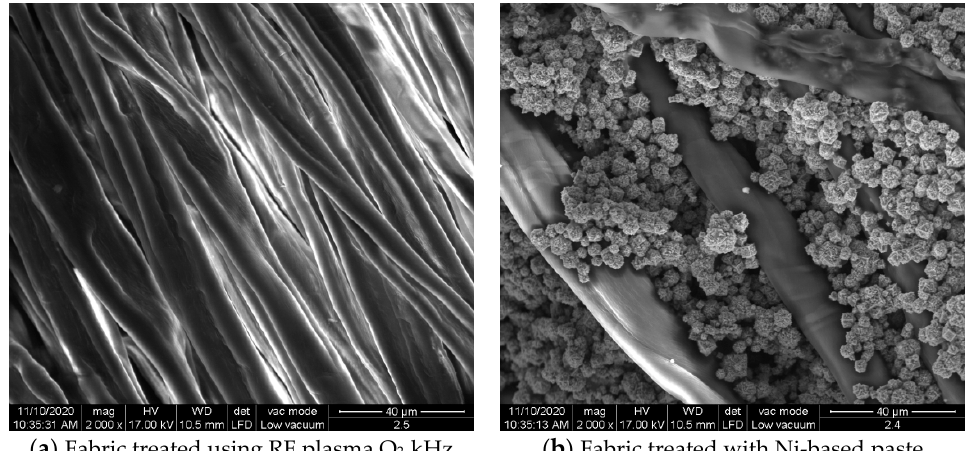
Figure 5. The sample was treated using RF 1 plasma O 2 using MHz generator and power 200 W. ( a ) represents the image of the sample treated using RF plasma O 2 MHz and power 200 W, respective ( b ) represents the sample treated with Ni-based paste.